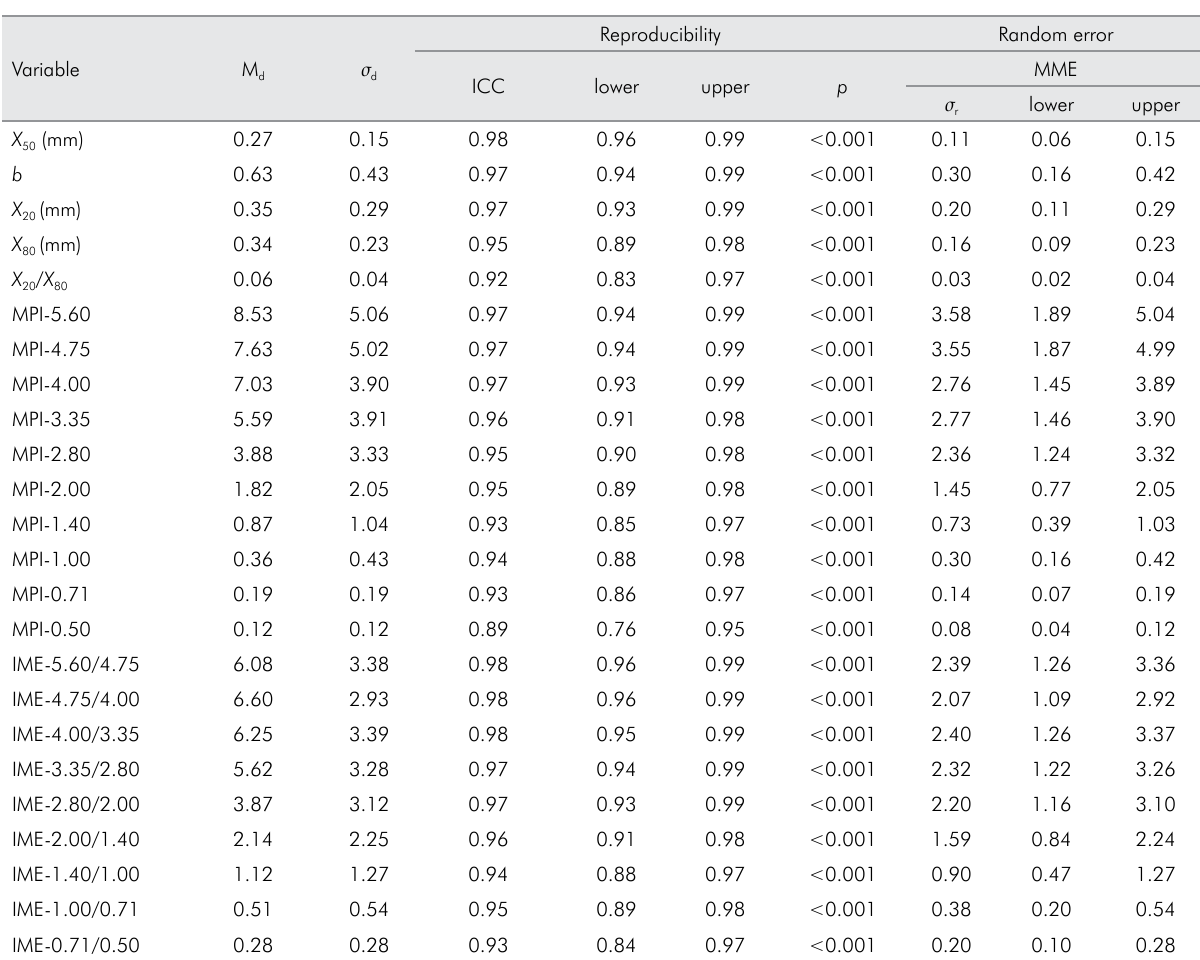
table 2. Intra-examiner reproducibility and random error in average means of absolute differences, according to the multiple sieve method (n =